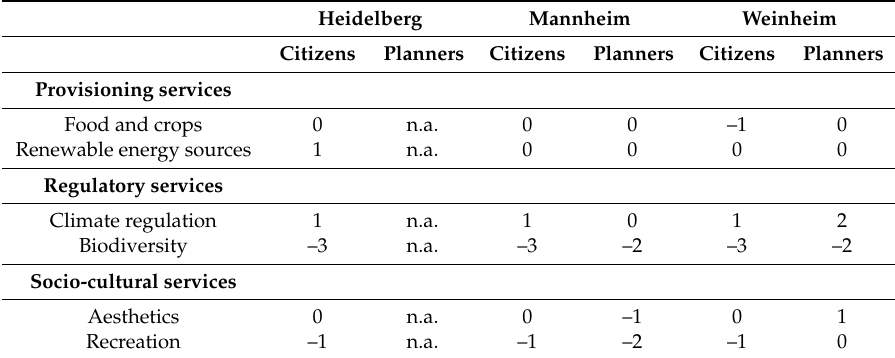
Table 4. Budget matrix for selected ecosystem services for the three study sites. Positive figures denote ecosystem service supply exceeds demand by stakeholders, negative figures denote ecosystem service demand by stakeholders exceeds